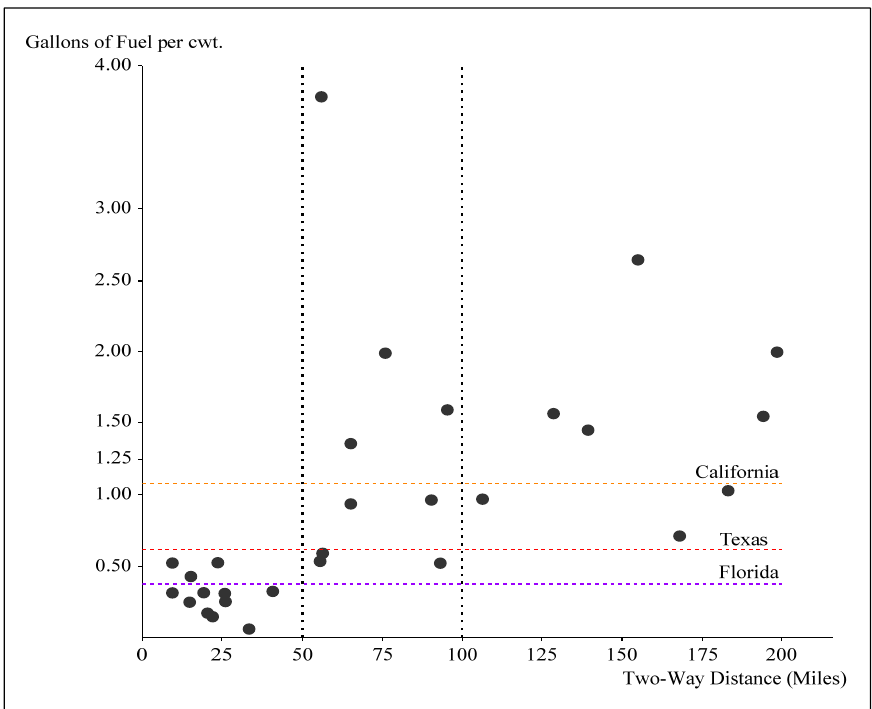
Figure 3. Comparing Local and Conventional Transportation Efficiencies by Travel Distance to